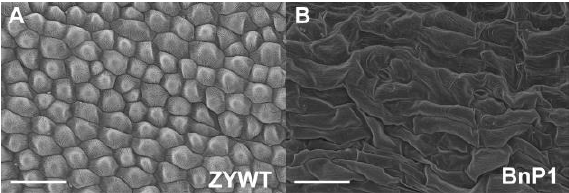
Figure 2. Scanning electron micrograph. ( A ) A wild flower with normal petals of B. napus ; ( B ) a transgenic line (BnP1) with irregularly shaped cells in petals. Bars = 50 µ m.